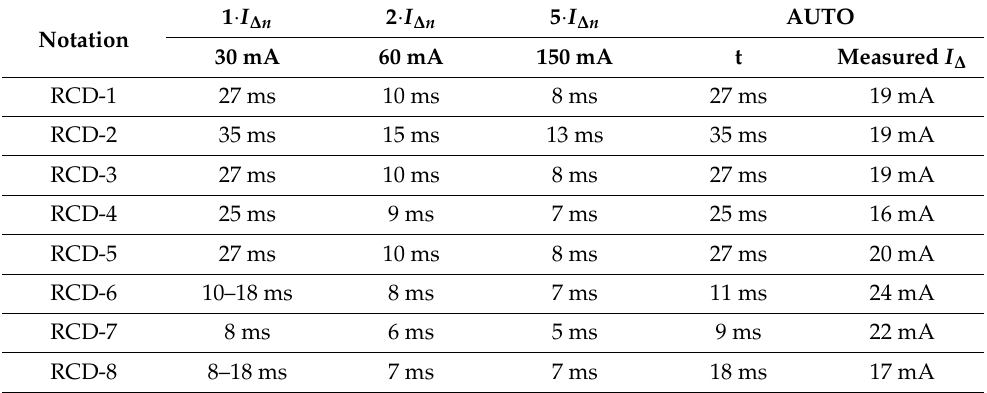
Table 3. A summary of break times for RCD circuit breakers measured with MRP-201 (sine excitation waveform of 50 Hz and initial phase 0°).